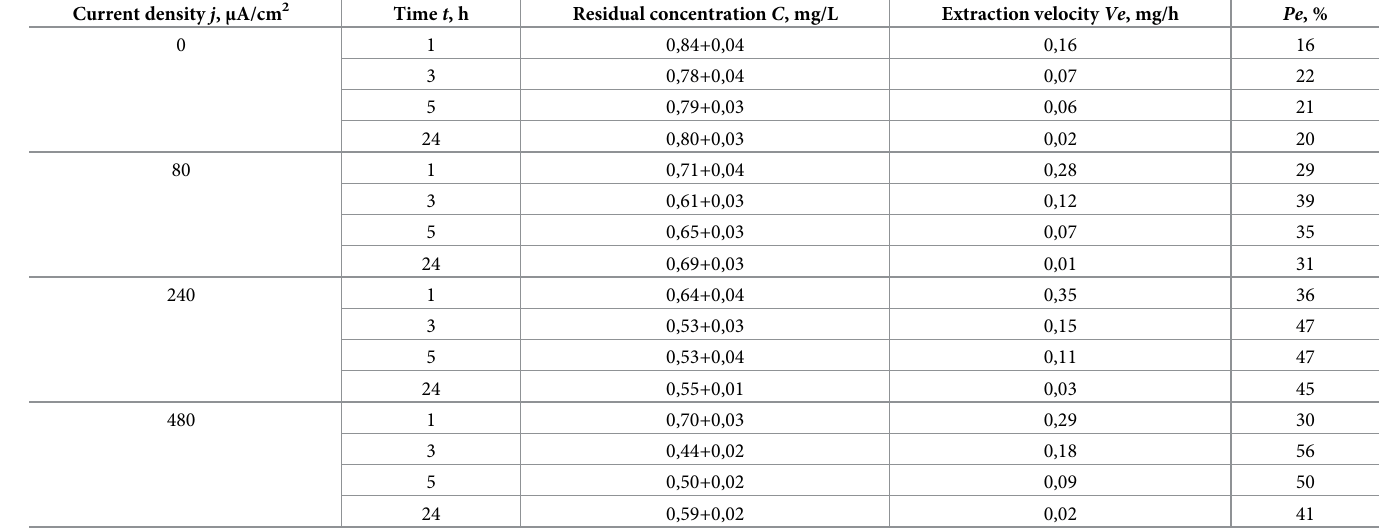
Table 2. Residual concentration ( C ), purification efficiency Pe , extraction velocity ( Ve ) of copper cations from a CuSO 4 solution ( C initial = 1 mg/L Cu 2 + ) by duck- weed vs current densities ( j ) ( H = 2 kA/m). Current density j , μ A/cm